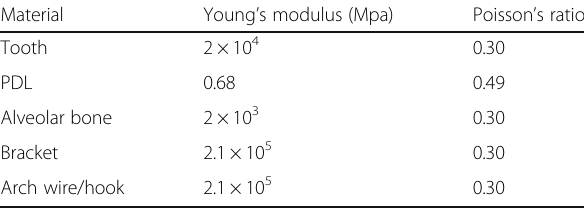
Table 2 Material properties used in FEM model Material